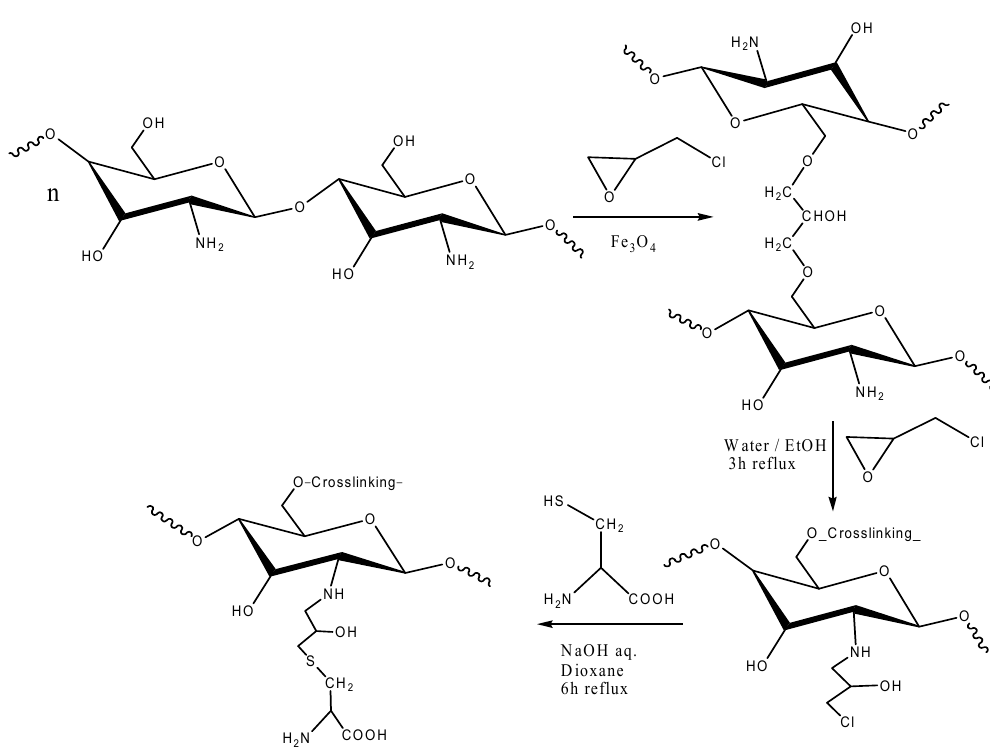
Figure 1. Scheme for the synthesis of cysteine-functionalized chitosan magnetic nano-based